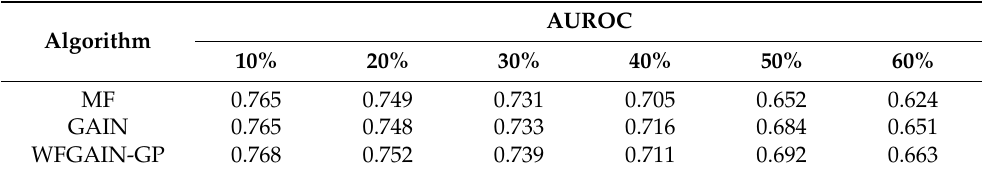
Table 8. AUROC values of various models for imputation result in different missing rates. Area Under the Receiver Operating Characteristic Curve (AUROC) represents the area under the receiver operating characteristic curve, which is a widely used metric for evaluating the performance of binary classifiers and is commonly used to compare the performance of different